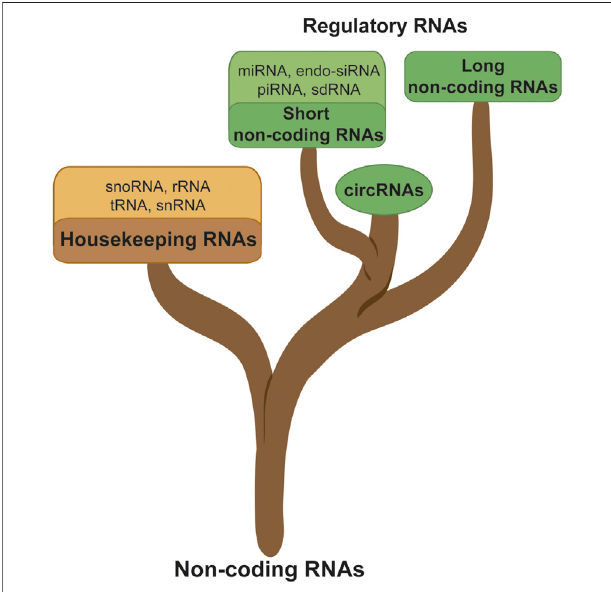
FIGURE 1 | Noncoding RNA classi fi cation; ncRNAs are subdivided into different branches such as the housekeeping or regulatory RNA, sncRNA, lncRNA, and